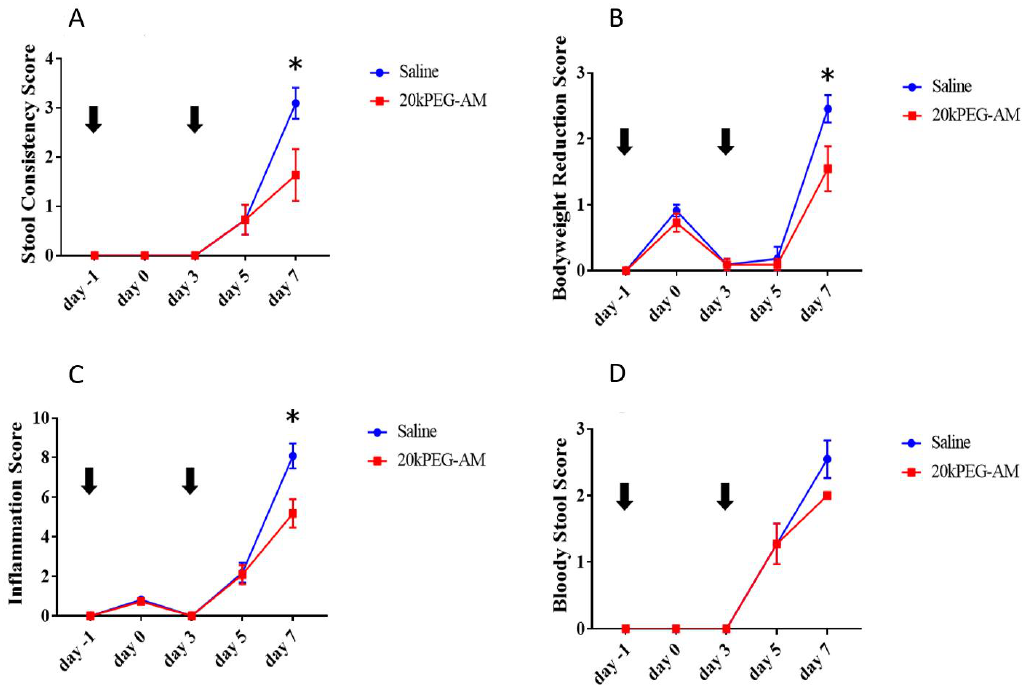
Figure 6. Comparison of scores in the DSS-induced colitis model following treatment with 20kPEG-AM (n = 11 mice/group). Double injection protocol: ( A ) stool consistency score, ( B ) bodyweight reduction score, ( C ) inflammation score, and ( D ) bloody stool score. Results are shown as means ± S.E.M. * p < 0.001 versus control.